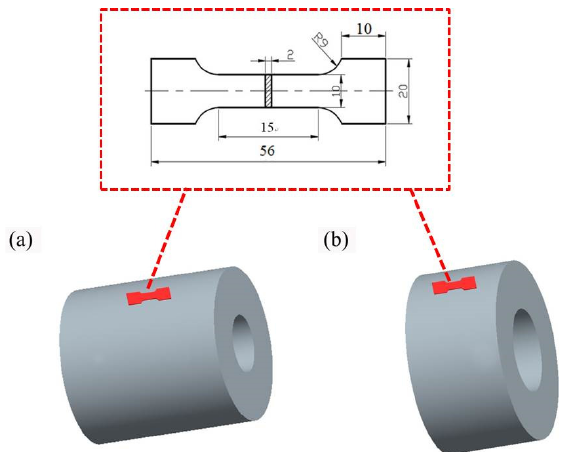
Figure 3. The schematic and sampling positions of the tensile samples: ( a ) Liquid forging part, ( b ) isothermal forging part.